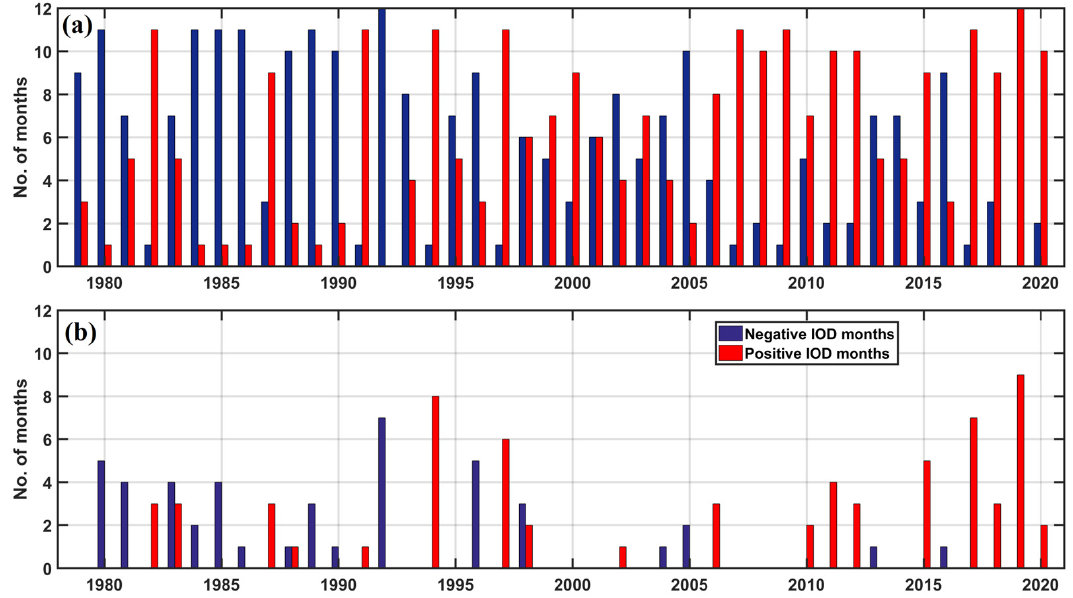
Figure 13. Total number of positive and negative months based on DMI. ( a ) The upper panel shows the total number of months having DMI < 0 (blue) and DMI > 0 (red). ( b ) Bottom panel; same as the upper panel, but for DMI > 0.4 and DMI < − 0.4.